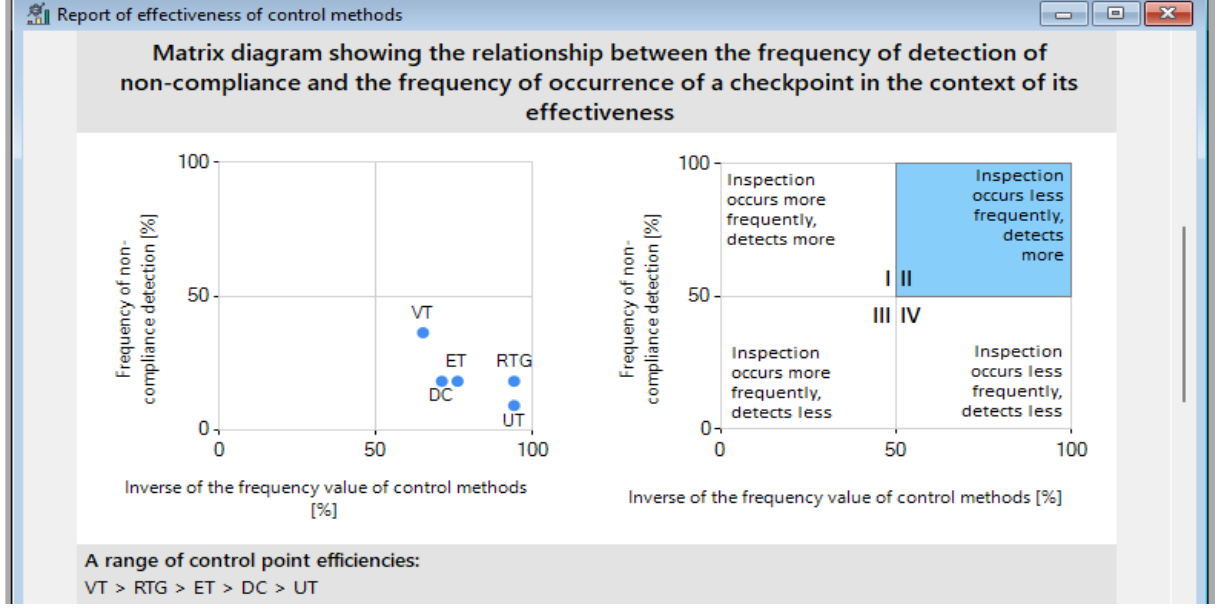
Figure 7. Part two of the report on the effectiveness of control methods — analysis of the level of effectiveness of detection methods.